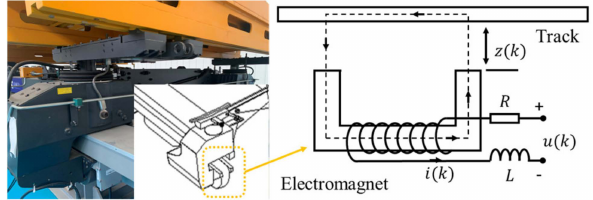
Figure 7. Schematic diagram of single point suspension system of maglev